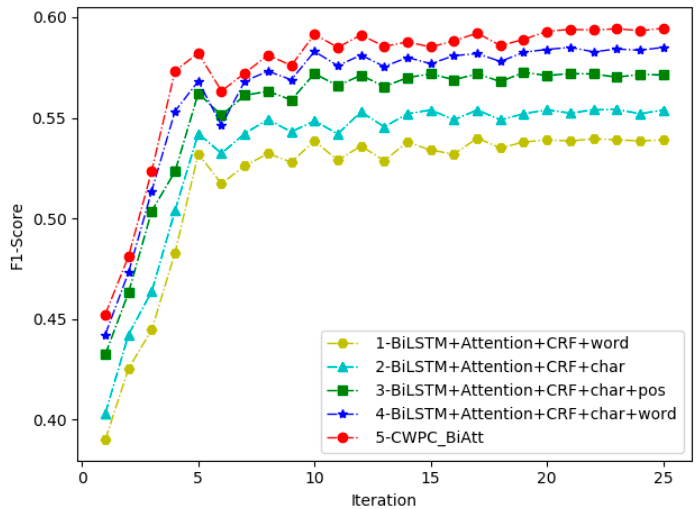
Figure 6. As shown in CWPC_BiAtt and other experiments, the results gained by using comprehensive-embedding are better than that selectively utilizing char-embedding, word-embedding, and pos-embedding. The F1-score of CWPC_BiAtt has increased by 1.2% than that of (char + word), in that comprehensive-embedding provides an index for sentences, which records the positional relation among embedding.